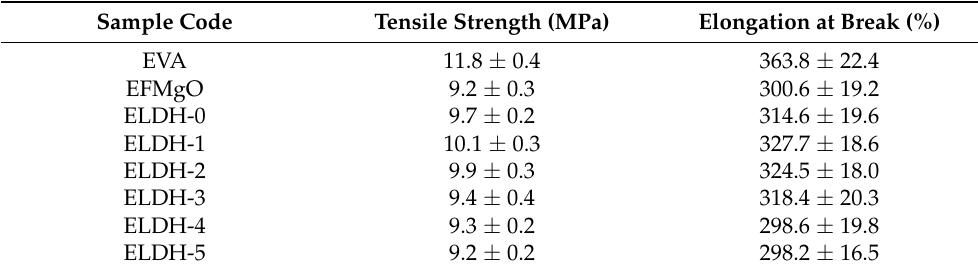
Table 5. Mechanical properties for EVA/LDHs